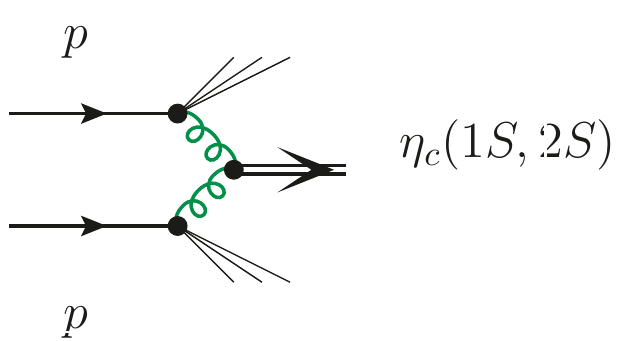
Figure 1 . Generic diagram for the inclusive process of (cid:17) c (1S) or (cid:17) c (2S) production in proton-proton scattering via two gluons